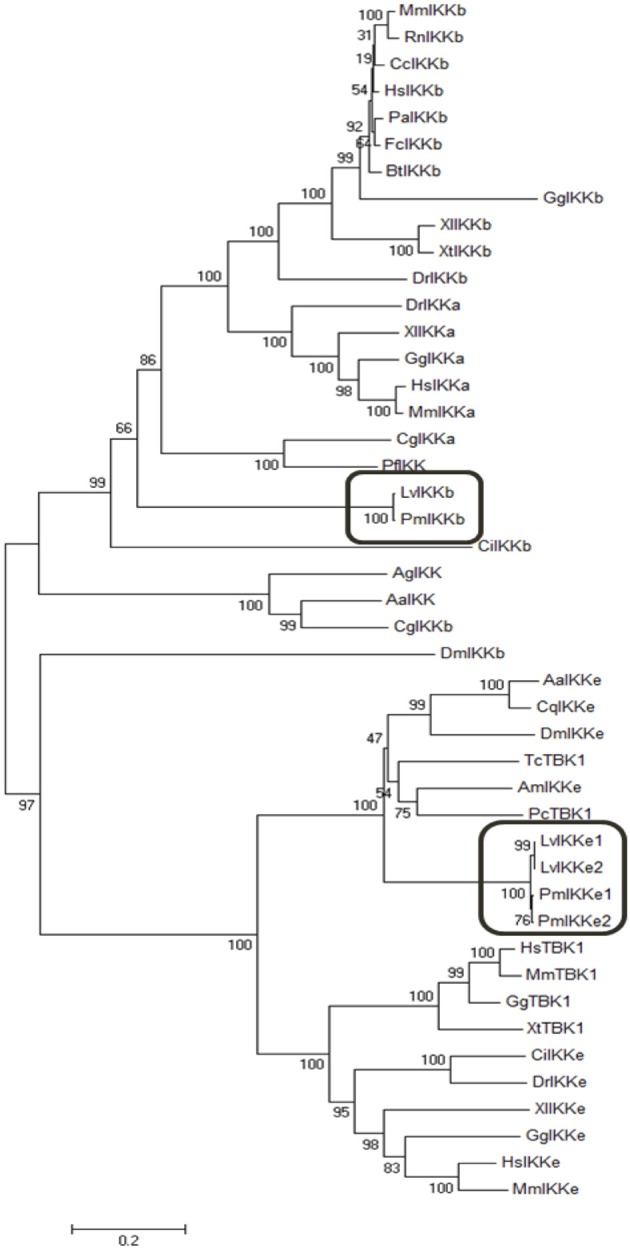
Phylogenetic analysis of IκB kinases (IKKs) and IKK-family proteins from Penaeus monodon and various species. The neighbor joining phylogenic tree was constructed in MEGA 7.0 software based on the amino acid sequences of IKKβ, IKKε, and IKK-family proteins from vertebrates and invertebrates. Bootstrap sampling was reiterated for 1,000 times. The deduced amino acid sequences retrieved from various species include; Penaeus monodon IKKβ (PmIKKβ, MK331816); Litopenaeus vannamei IKKβ (LvIKKβ, AEK86518); Mus muculus IKKβ (MmIKKβ, NP_001153246); Rattus norvegicus IKKβ (RnIKKβ, AAF21978); Castor canadensis IKKβ (CcIKKβ, P_020011901); Homo sapiens IKKβ (HsIKKβ, NP_001547); Pongo abelii IKKβ (PaIKKβ, XP_024106853); Felis catus IKKβ (FcIKKβ, XP_003984800); Bos tausus IKKβ (BtIKKβ, NM_174353); Danio rerio IKKβ (DrIKKβ, NP_001116737); Xenopus tropicalis IKKβ (XtIKKβ, NP_001005651); Xenopus laevis IKKβ (XlIKKβ, NP_001085125); Cricetulus griseus IKKβ (CgIKKβ, XP_027293025); Gallus gallus IKKβ (GgIKKβ, NP_001026568); Drosophila melanogaster IKKβ (DmIKKβ, AAG02485); Aedes aegypti IKK (AaIKK, EAT45468); Anopheles gambiae IKK (AgIKK, XP_553095); Ciona intestinalis IKK (CiIKK, XP_002125567); Pinctada fucata IKK (Pf IKK, AAX56336); Mus musculus IKKα (MmIKKα, AAC52589); Homo sapiens IKKα (HsIKKα, NP_001269); Crassostrea gigas IKKα (CgIKKα, NP_001295815); Xenopus laevis IKKα (XlIKKα, NP_001086127); Danio rerio IKKα (DrIKKα, AAW68010); Gallus gallus IKKα (GgIKKα, NP_001012922); Penaeus monodon IKKε1 (PmIKKε1, MK331817); Penaeus monodon PmIKKε2 (PmIKKε2, MK331818); Litopenaeus vannamei IKKε1 (LvIKKε1, AEK86519); Litopenaeus vannamei IKKε2 (LvIKKε2, AEK86520); Culex quinquefasciatus IKKε (CqIKKε, XP_001848400); Drosophila melanogaster IKKε (DmIKKε, NP_724278); Apis mellifera IKKε (AmIKKε, XP_396937); Aedes aegypti IKKε (AaIKKε, XP_001650774); Homo sapiens IKKε (HsIKKε, NP_054721); Mus musculus IKKε (MmIKKε, EDL39711); Xenopus laevis IKKε (XlIKKε, NP_001089830); Danio rerio IKKε (DrIKKε, NP_001002751); Ciona intestinalis IKKε (CiIKKε NP_001072034); Gallus gallus IKKε (GgIKKε, XP_428036); Xenopus tropicalis TBK1 (XtTBK1, NP_001135652); Homo sapiens TBK1 (HsTBK1, NP_037386); Macaca mulatta TBK1(MmTBK1, NP_001248122); Phalacrocorax carbo TBK1 (PcTBK1, XP_009506274.1); Gallus gallus TBK1 (GgTBK1, NP_001186487) and Tribolium castaneum TBK1 (TcTBK1, XP_969718).